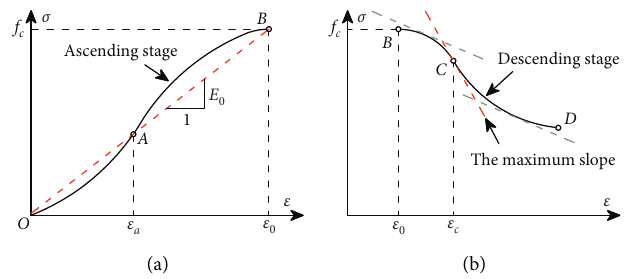
Figure 18: Determinations of dividing